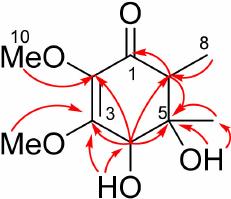
Figure 2. Key HMBC correlations in lopouzanone A ( 1